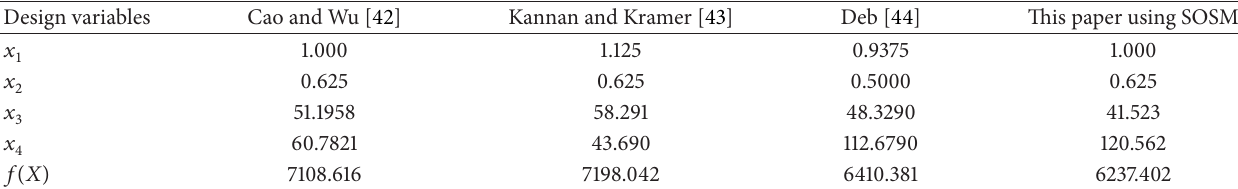
Table 6: Comparison of optimal results for the design of a pressure